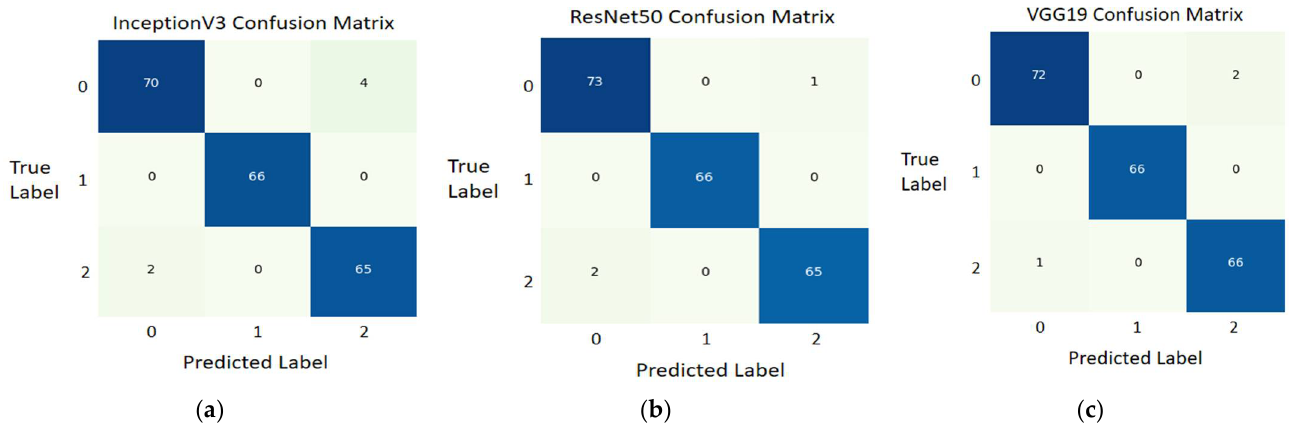
Figure 8. Three-class classifier confusion matrix; ( a ) Confusion matrix of InceptionV3 model; ( b ) Confusion matrix of ResNet50 model; ( c ) Confusion matrix of VGG19 model.